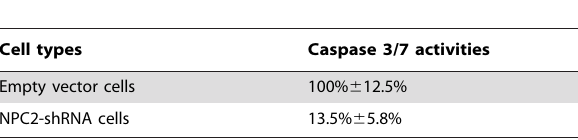
Table 1. Caspase 3/7 activities in cultured H460